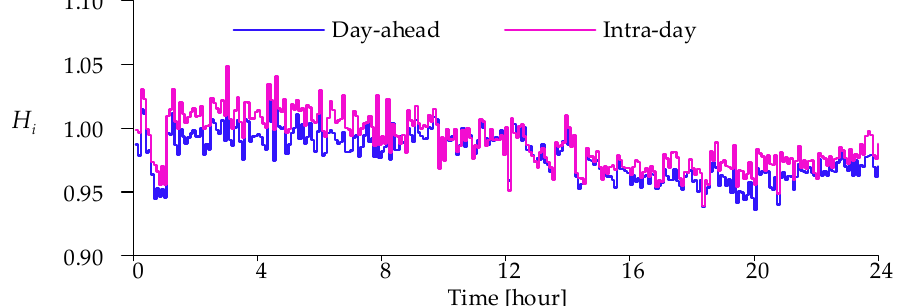
Figure 12. Comparison of real H i values before and after intra-day adjustment under clear sky conditions.